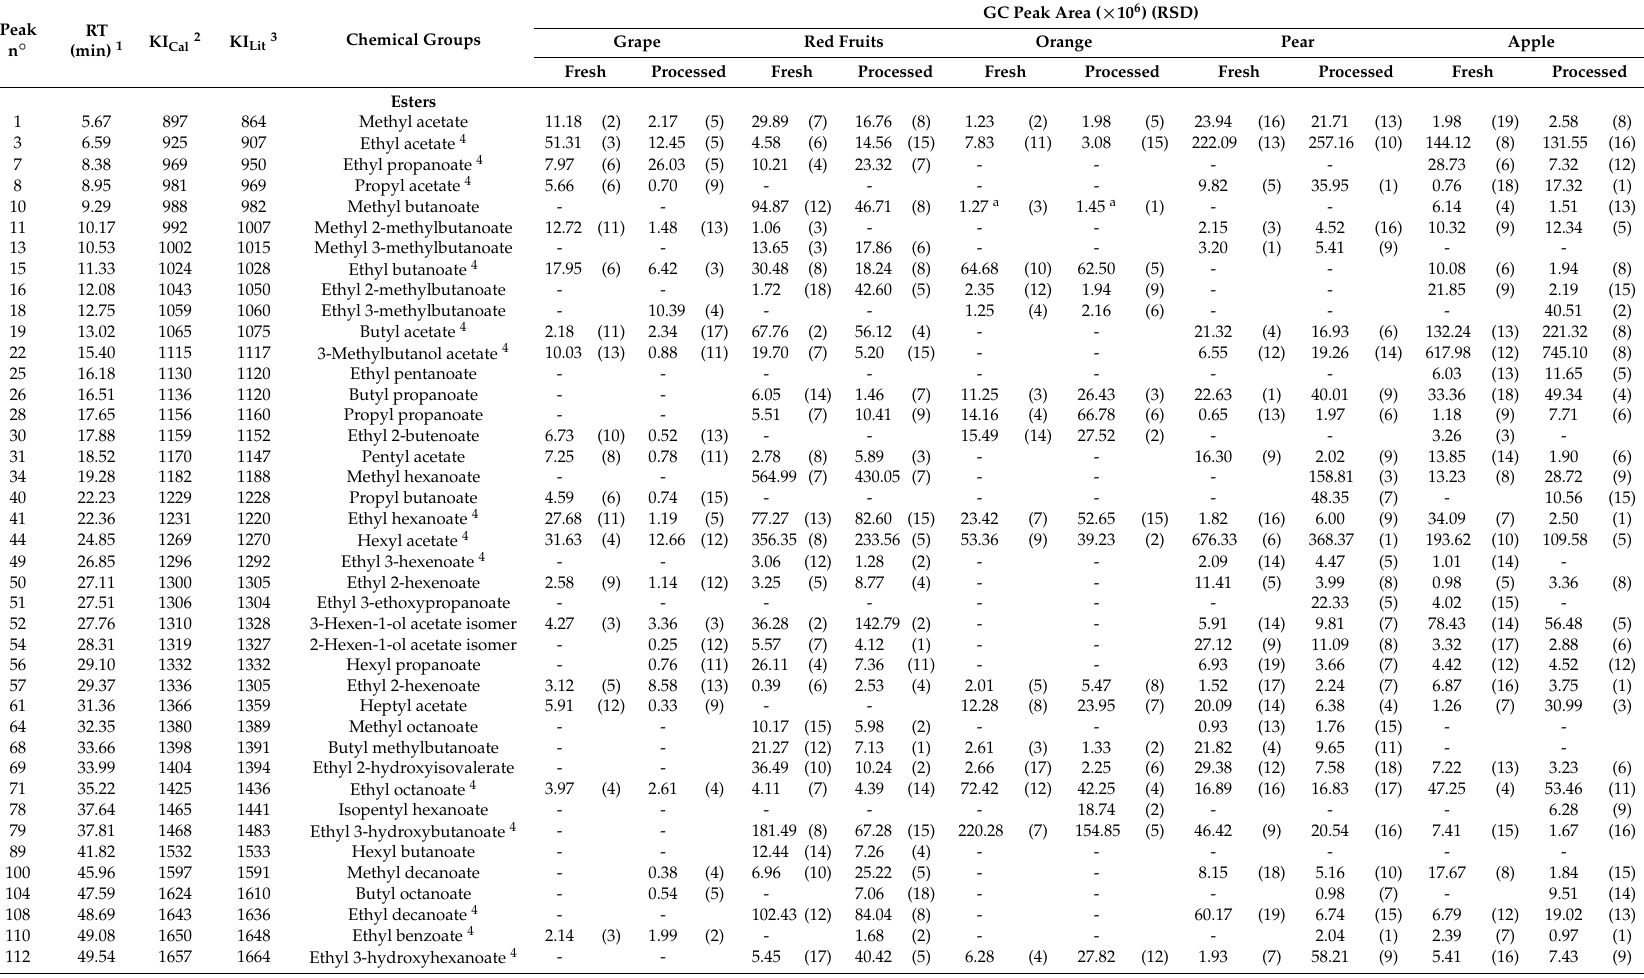
Table 1. GC peak area ( × 10 6 ) of volatile organic compounds (VOCs) identified in fresh and processed fruit